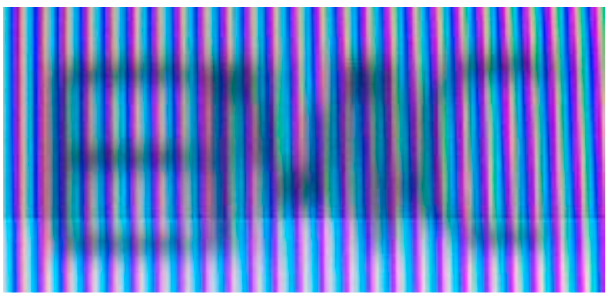
Figure 11. Character string displayed on monitor (1280 × 1024 pixels).